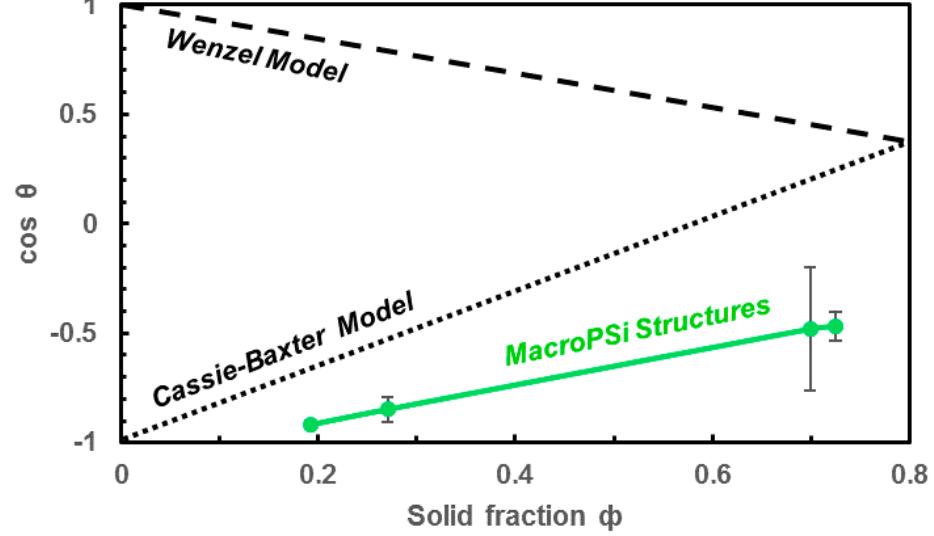
Figure 7. Comparison of experimental data of WCAs at MacroPSi surfaces and theoretical models.